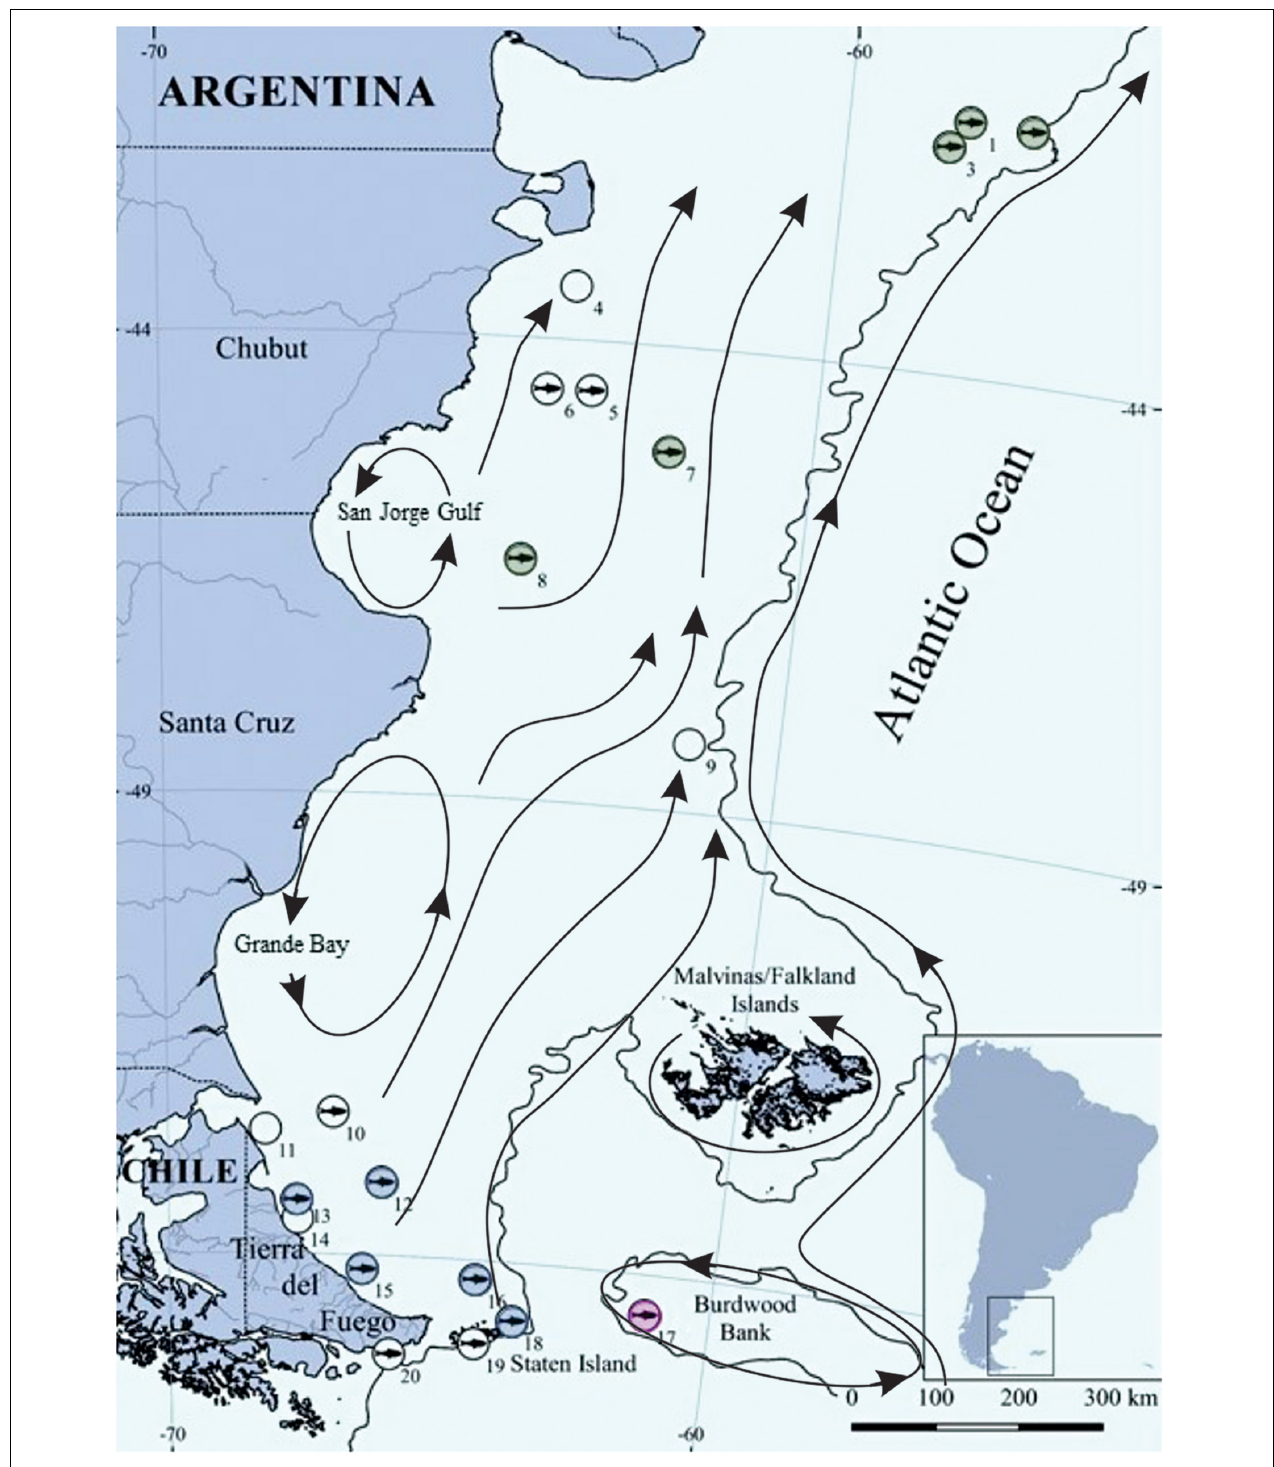
FIGURE 1 | Study area and sampling stations during November-December 2009 in the southwestern Atlantic Ocean. The solid black line represents the 200 m isobath, circles with a fish represent stations where C. trigloides was captured and empty circles represent stations where C. trigloides was not captured. Different colors indicate different geographic areas (NPS: northern Patagonia shelf, green; SPS: southern Patagonia shelf, blue; and BB: Burdwood Bank, pink). Stations without colors were not included in elemental analyses. Black arrows represent main currents over the PS according Palma et al. (2008).